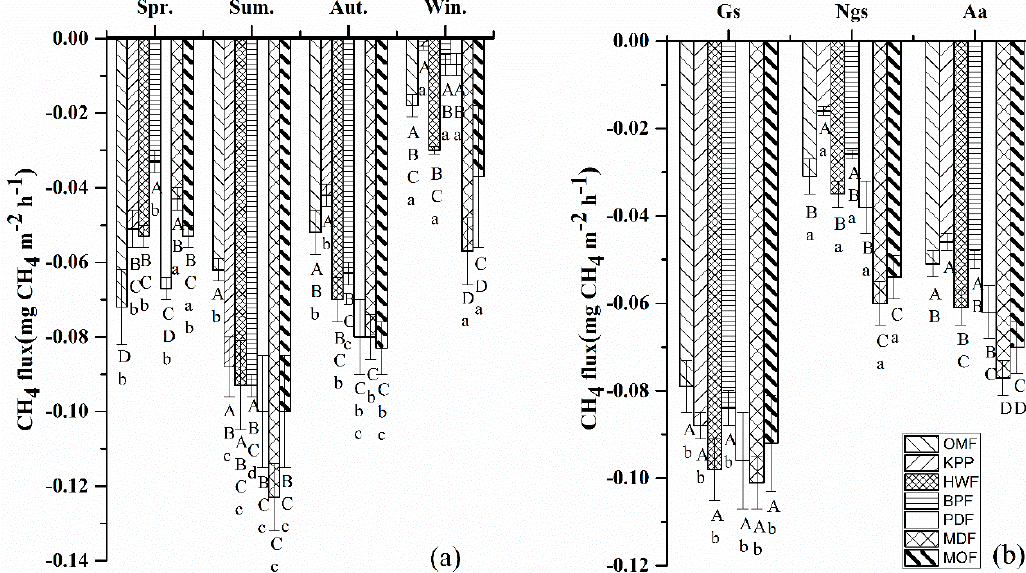
Figure 2. Seasonal variations ( a ), dynamics of Gs and Ngs ( b ), and the annual average ( b ) of methane fluxes from the over-mature forest, Korean pine plantation, and five secondary forests at the Maoershan Ecosystem Research Station in Northeast China. The lowercase letters indicate statistically significant di ff erences within treatments among di ff erent seasons. The capital letters indicate statistically significant di ff erences within seasons among di ff erent treatments. Abbreviations: Spr., Spring; Sum.,